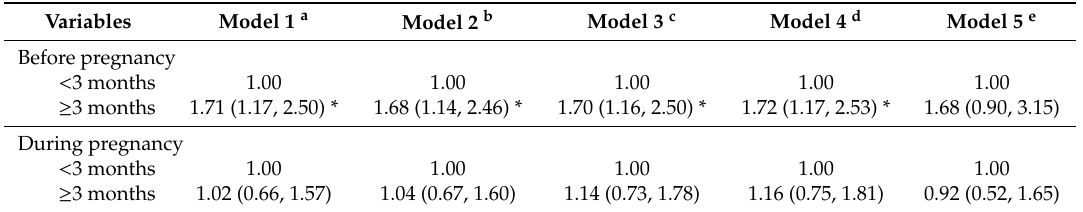
Table 3. Associations between duration of folic acid supplementation and gestational diabetes